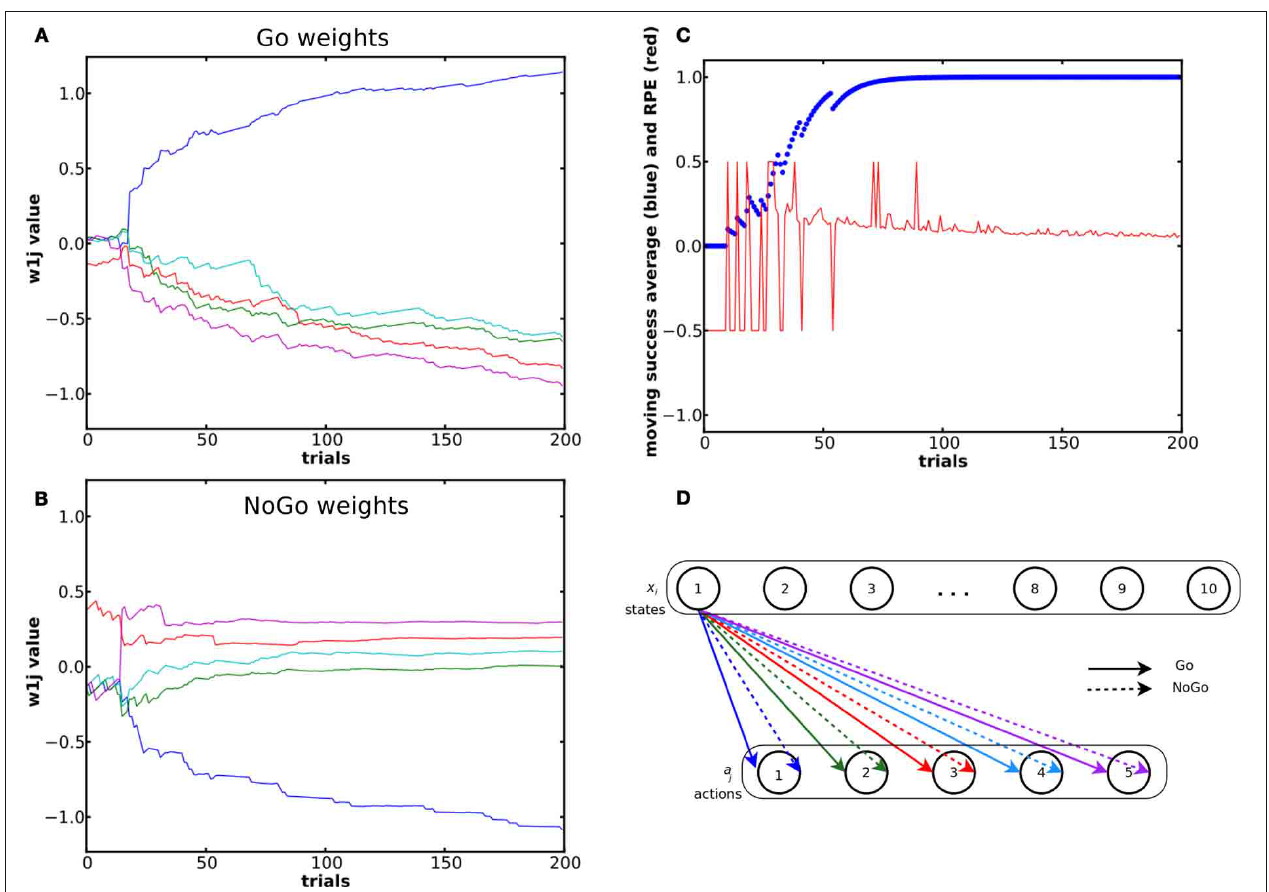
FIGURE 3 | Evolutionof the weightsand of the RPE during a simple learning task. (A) and (B) showsdynamics of the weightsfrom state 1 (out of 10) in the Go (A) and NoGo (B) pathwaysduringasimple learning task. Theblue curve representsthe weightbetweenstate 1 andthe rewardedaction. (C) Movingaverage of reward over ten trials and RPE value for the same simulation. (D) Color coding of the different weights and the associated actions.